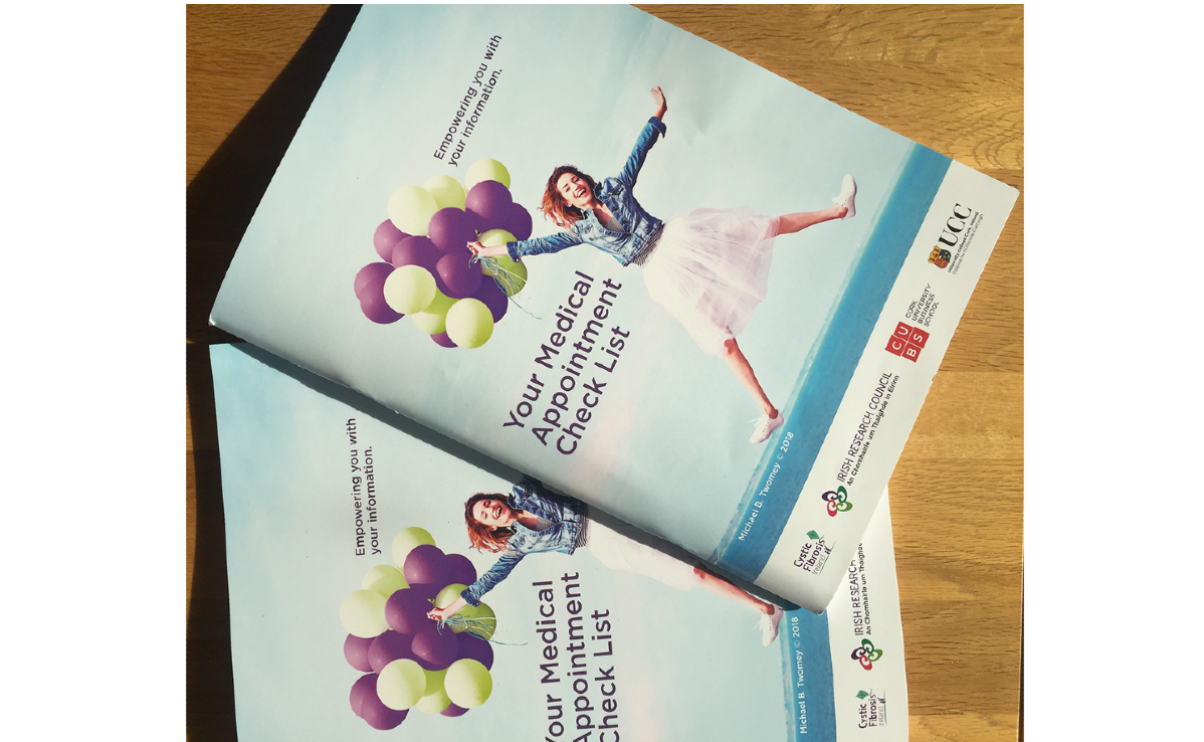
Figure 8. The checklist